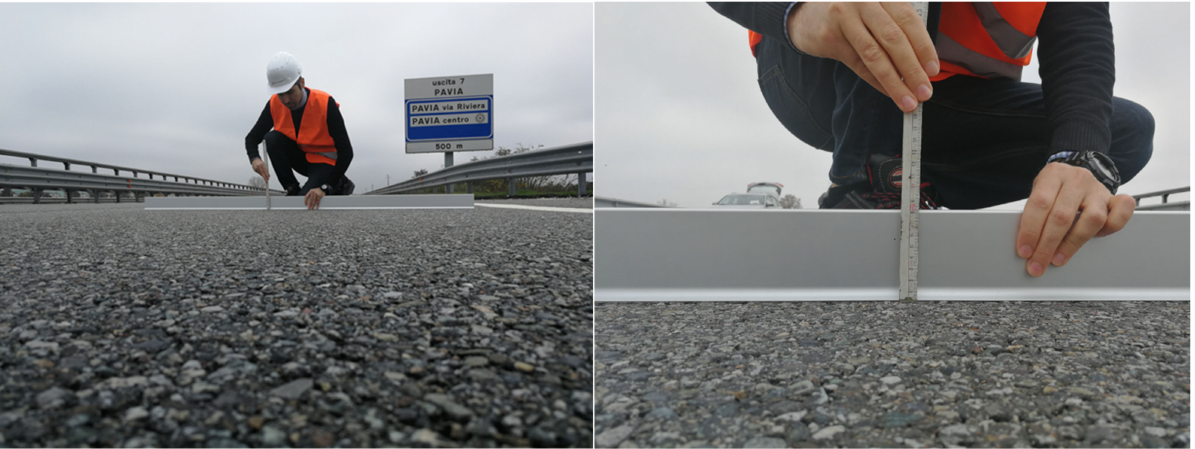
Figure 15. Rutting control of the pavement wheel paths. Autumn